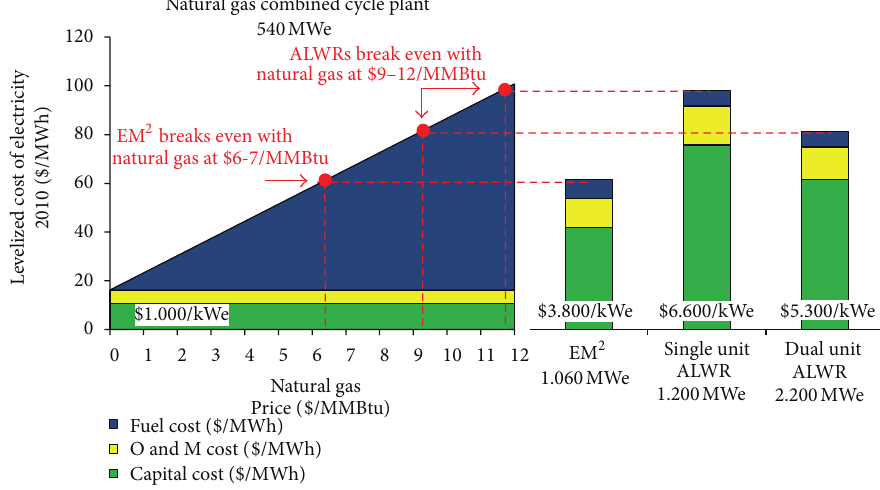
Figure 11: Comparison of EM 2 power cost versus other generating